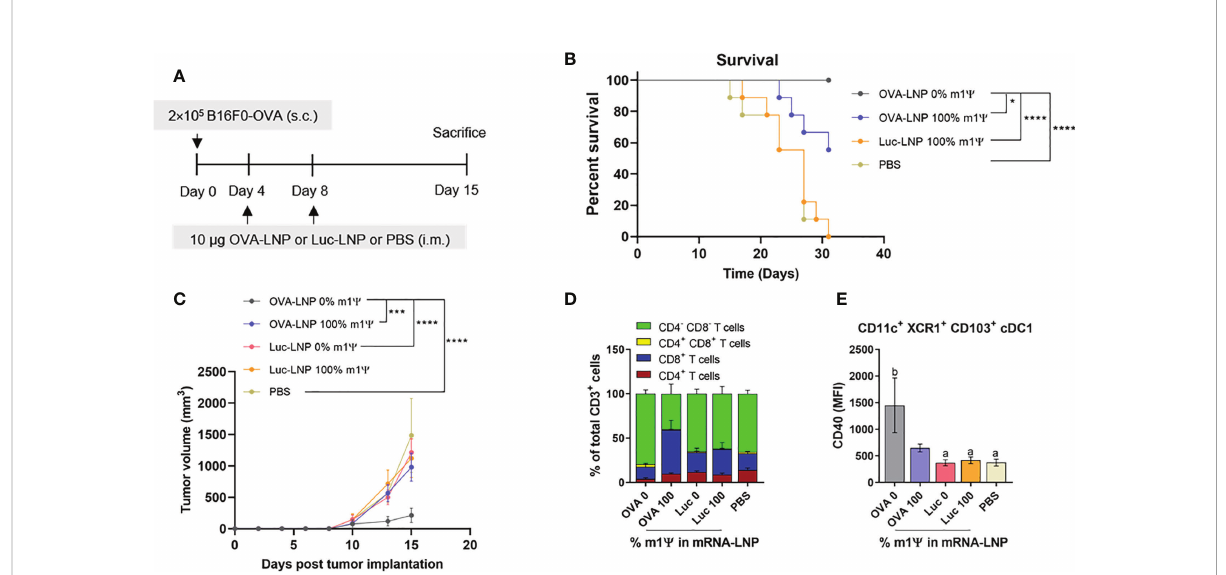
FIGURE 4 Intramuscular immunization of unmodi fi ed OVA-LNP inhibits tumor growth and prolongs survival. (A) Schematic representation of the immunization and tumor implantatioin schedule. (B) The percentages of survival mice was followed until day 31 after tumor implantation. Mice that reached the maximal allowed tumor size of 20 mm, or 400 mm 2 were euthanized and recorded as having tumor areas of 400 mm 2 ( n = 9). (C) Tumor volume was shown during the 15 days after tumor implantation ( n = 10). (D) Compositions of tumor-in fi ltrating T cells and (E) MFI of costimulatory molecule CD40 on cDC1 are shown ( n = 6). The results are presented as the mean ± SEM. Statistical signi fi cance: (*) p < 0.05, (***) p < 0.001 and (****) p < 0.0001 by two-way ANOVA with Bonferroni multiple comparisons test. Survival curves were compared using log-rank (Mantel – Cox)